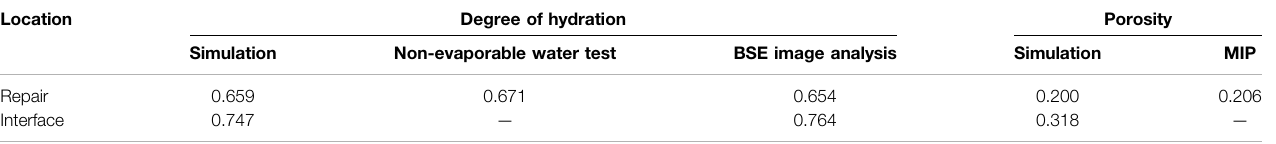
TABLE4| Comparisonbetweenthesimulationresultsandexperimentalresults(Zhouetal.,2016)ofthedegreeofhydrationandporosityinthebulkrepairmaterialandatthe interface.